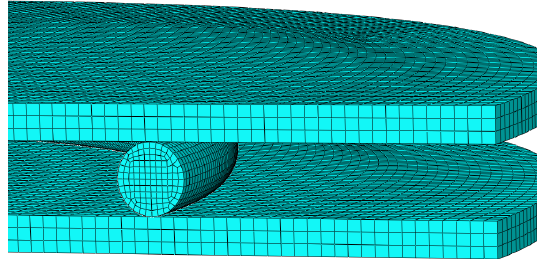
Figure 4. Meshed O-ring segment in assembly between two steel plates (Young´s modulus: E = 210 GPa, Poisson’s ratio: ν = 0.3).